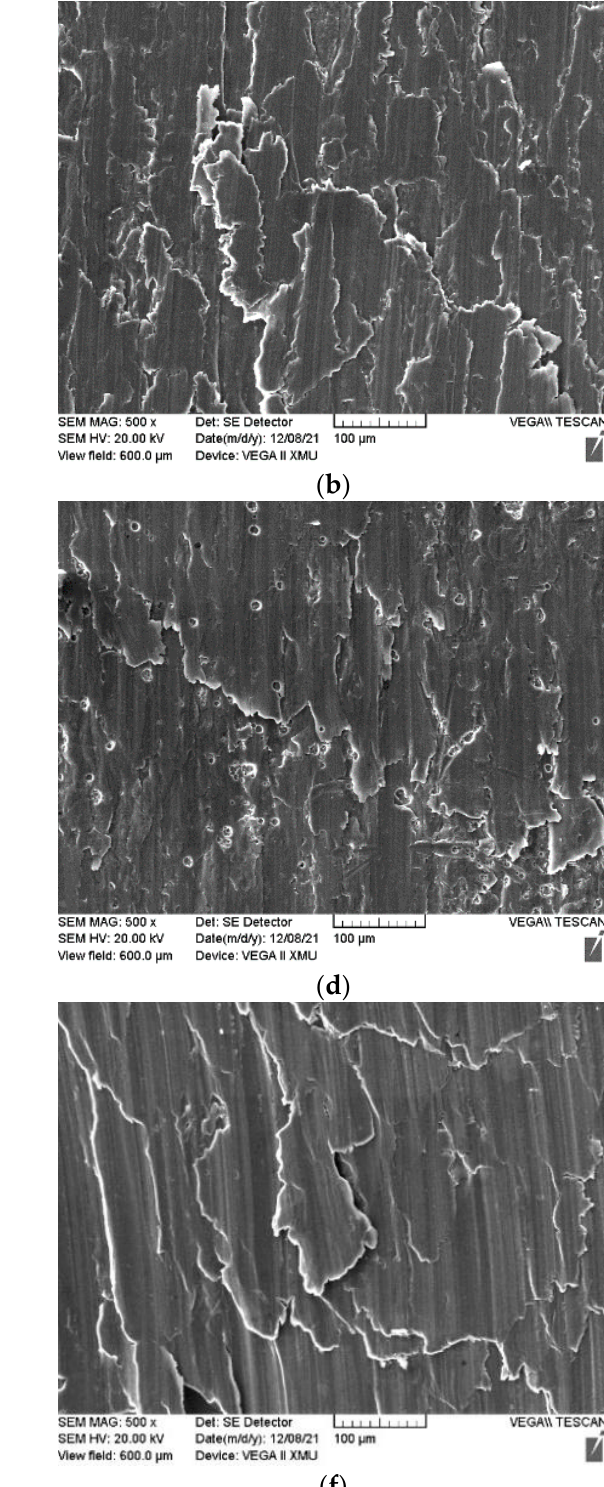
Figure 6. Surface morphology of specimens for SPIF, LUVIF and 2D-EUVIF. ( a ) 100×, SPIF; ( b ) 500×, SPIF; ( c ) 100×, LUVIF; ( d ) 500×, LUVIF; ( e ) 100×, 2D-EUVIF; ( f ) 500×, 2D-EUVIF; 2D-EUVIF is the abbreviation for 2D ellipse ultrasonic vibration incremental forming; LUVIF is the abbreviation for longitudinal ultrasonic vibration incremental forming; SPIF is the abbreviation for single-point incremental forming.